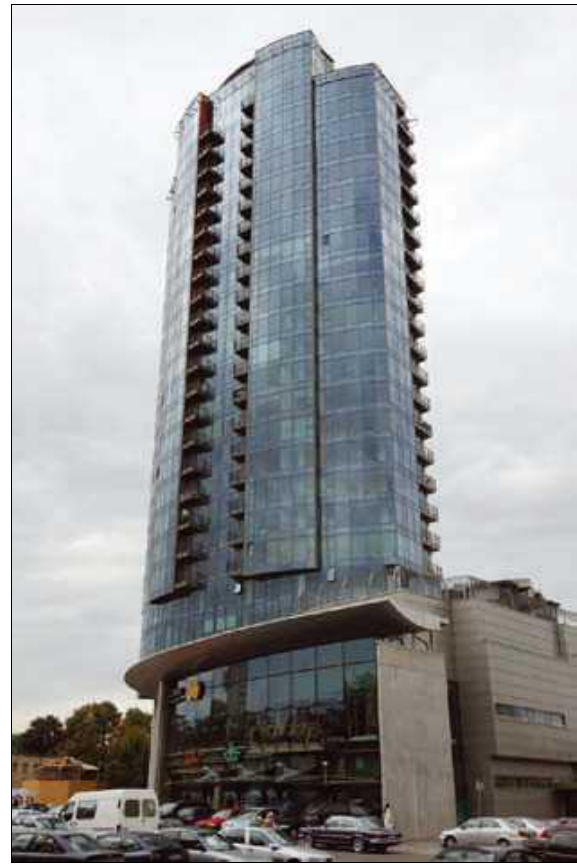
24 pav. Dau­giafu­nkcis kompleksas su­ dau­giabu­čiais Savanorių pr. (archit. L. Merkinas) Fig. 24. Mu­ltifu­nctional complex with blocks of flats on Savanoriai a­venu­e. a­rch. L.